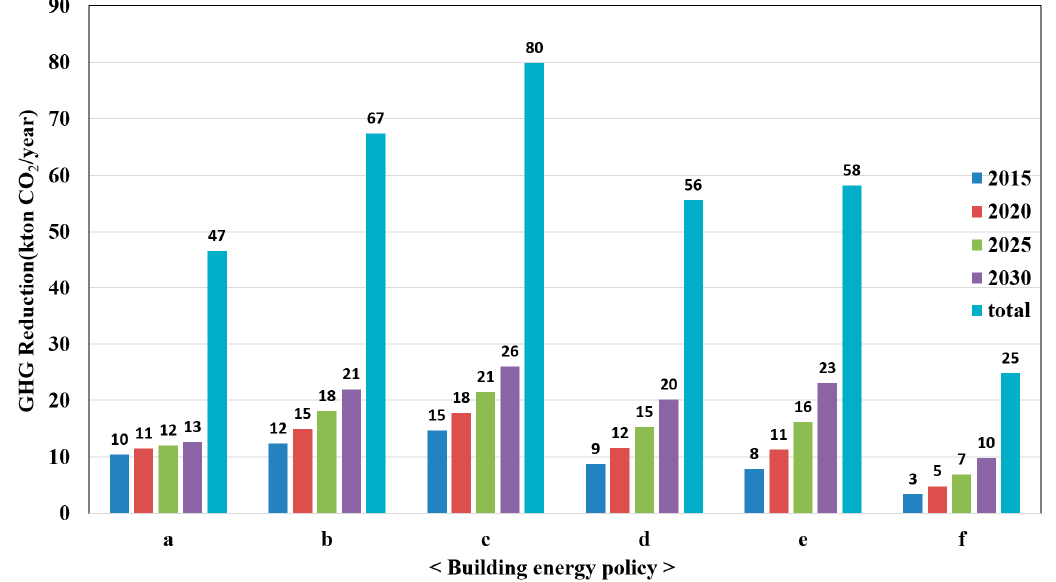
Figure 7. CO 2 emissions reduction potential of the building energy policy (BEP) scenario.